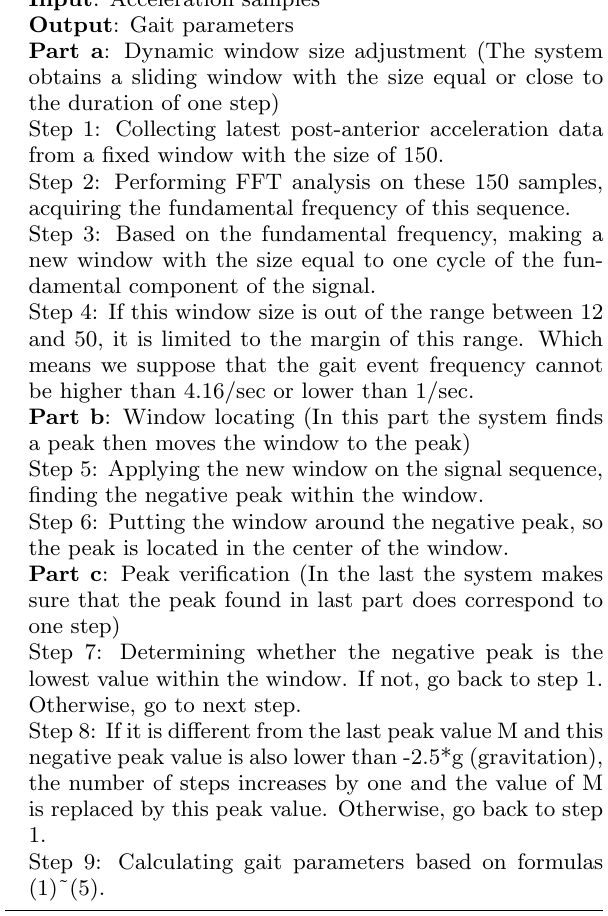
Algorithm 1 The gait analysis